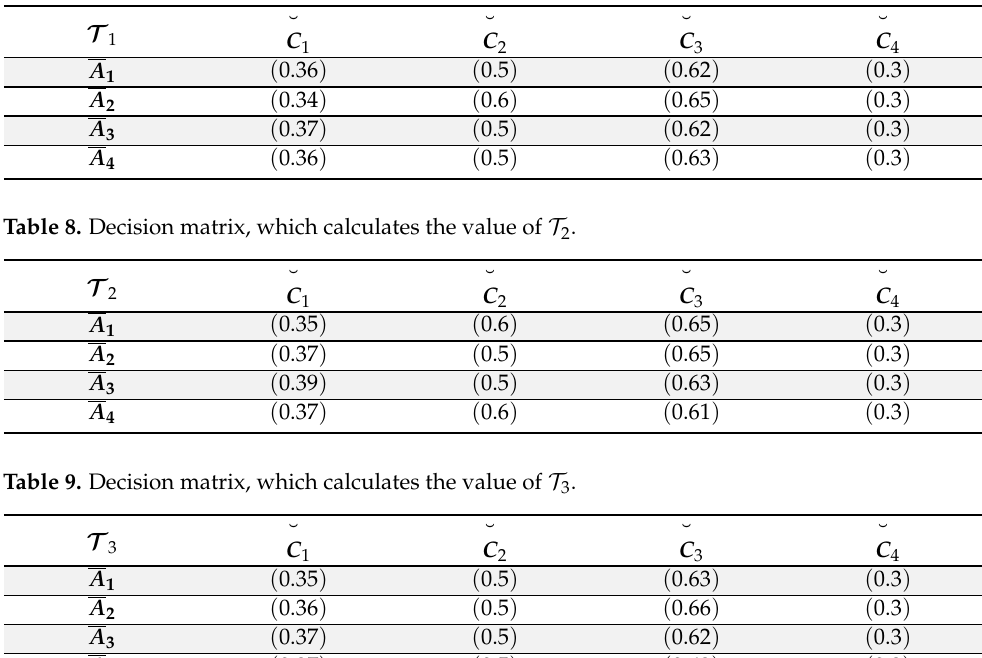
Table 7. Decision matrix, which calculates the value of T 1 .